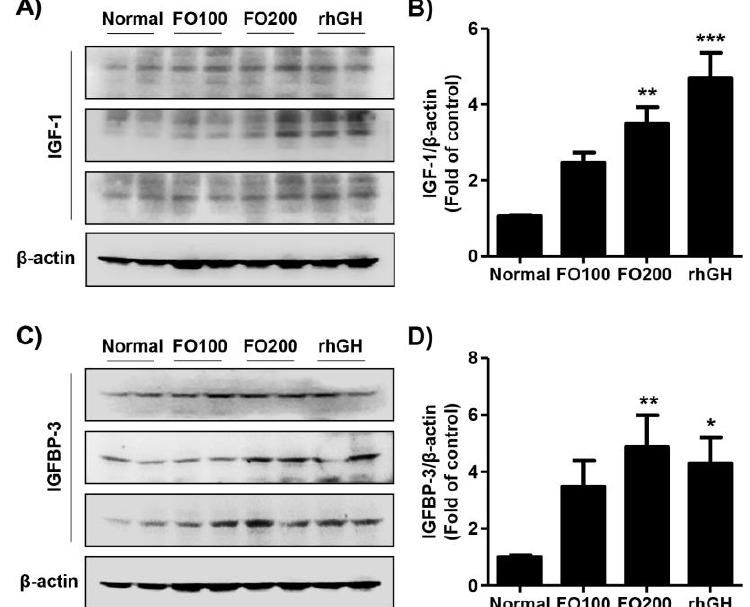
Figure 1. The protein expression of hepatic IGF-1 and IGFBP-3. Liver extract from Sprague-Dawley rats 14 days after treatment were analyzed via western blotting with anti-IGF-1 ( A ) and anti-IGFBP-3 ( C ) antibodies. β -actin served as the loading control. ( B , D ) Quantification of IGF-1 and IGFBP-3 levels. Data are expressed as means ± SD ( n = 6). * p < 0.05, ** p < 0.01 and, *** p < 0.001 vs. normal. IGF-1,